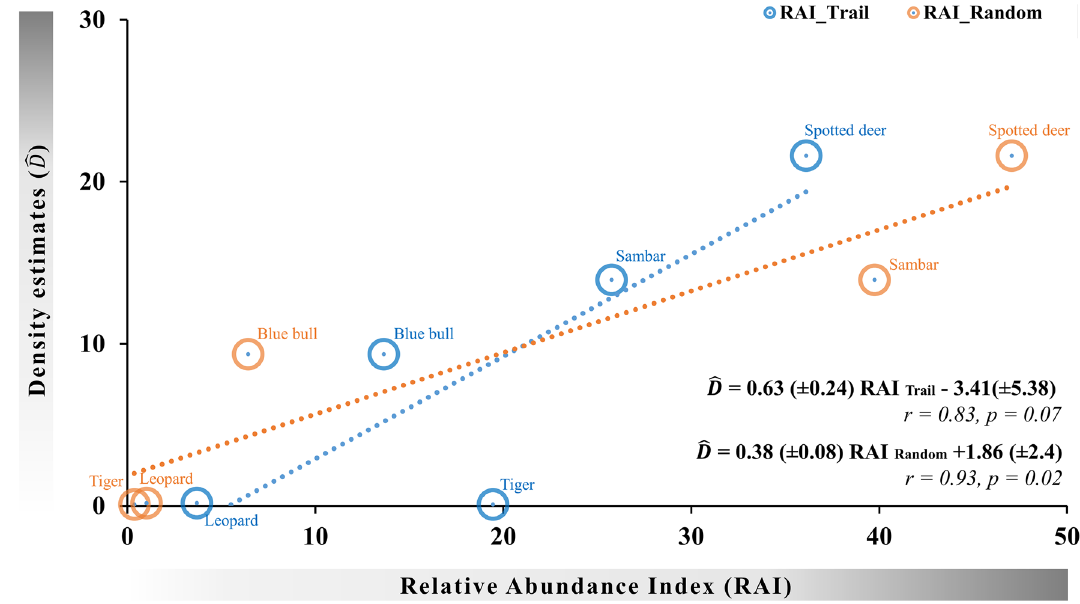
Figure 3. Scaling RAI values from different camera trap designs with absolute density. Only RAI’s from random camera trap placement designs had significant correlations with absolute density.